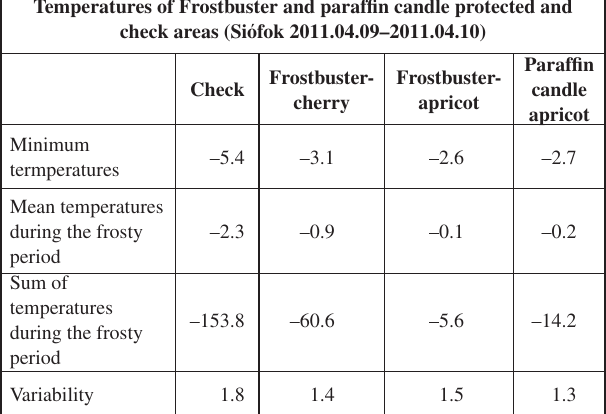
Table 1 – Temperatures measured during the experiment with two alternative anti-frost procedures at Siófok 2011.04.09-2011.04.10 Temperatures of Frostbuster and paraffi n candle protected and check areas (Siófok